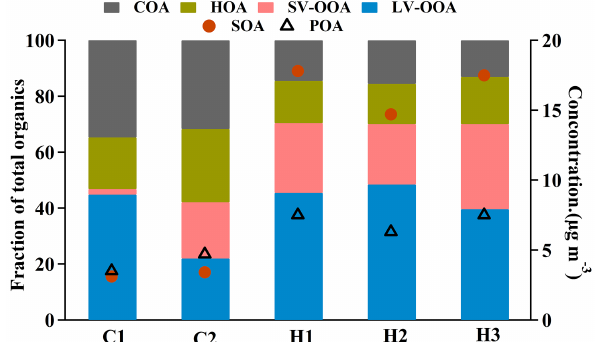
Figure 11. Mass fraction of hydrocarbon-like organic aerosol (HOA), cooking organic aerosol (COA), semi-volatile oxygenated organic aerosol (SV-OOA) and low-volatility oxygenated organic aerosol (LV-OOA) in color, and the mass concentration of POA and SOA marked by triangles and circles, respectively, during five peri- ods: clean periods (C1 and C2) and haze periods (H1, H2 and